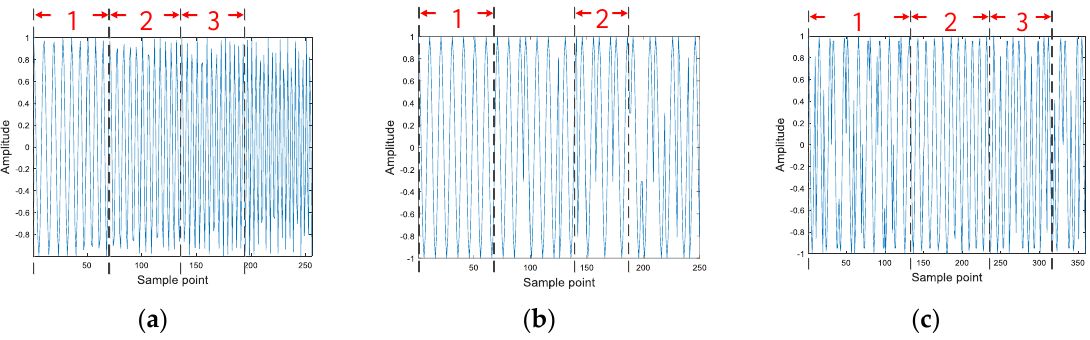
Figure 6. Time domain waveform analysis of LFM, T1 and P1: ( a ) LFM; ( b ) T1; and, ( c ) P1.